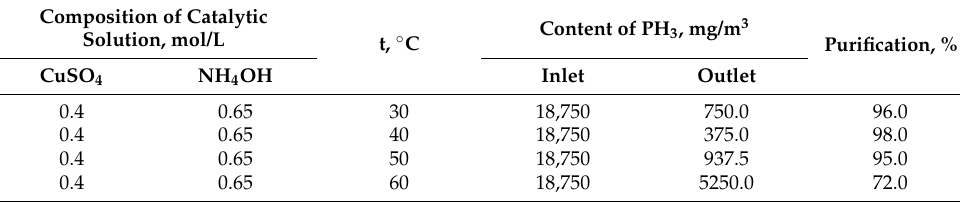
Table 3. The effect of temperature on the extent of purification from PH 3 at V PH3 = 40 mL/min. Composition of Catalytic Solution, mol/L